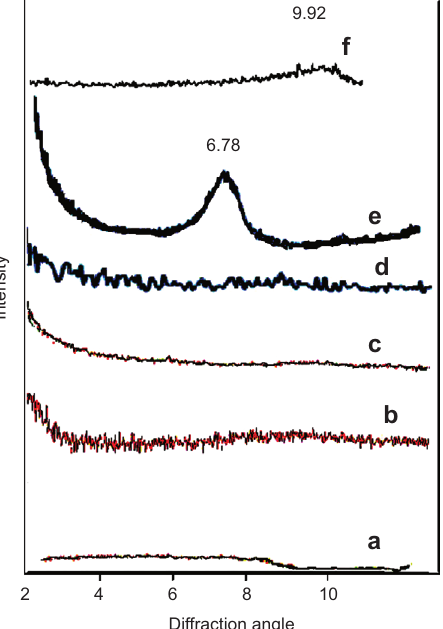
Figure 2 Wide-angle powder XRD patterns for PCN0.5, PCN1, PCN3, PCN5, organoclay, and MMT/Na +